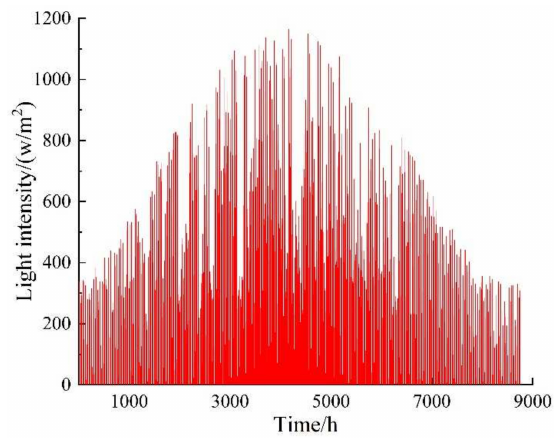
Figure 9. Full year light intensity prediction